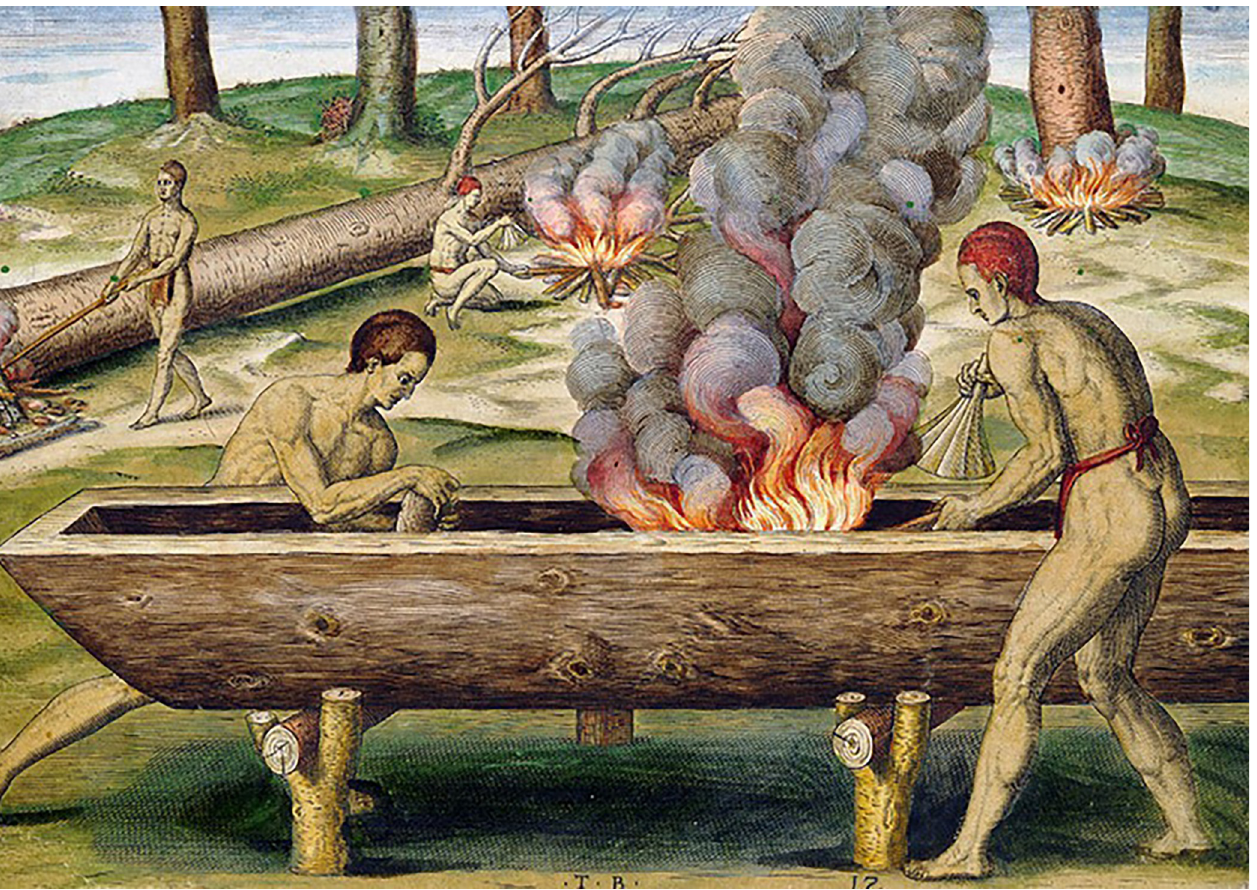
Fig 8. Mapuche burial, c. 1900 (in Chapanoff 2020: 14). The photograph shows a funeral ritual with a wampo beside the rewe .